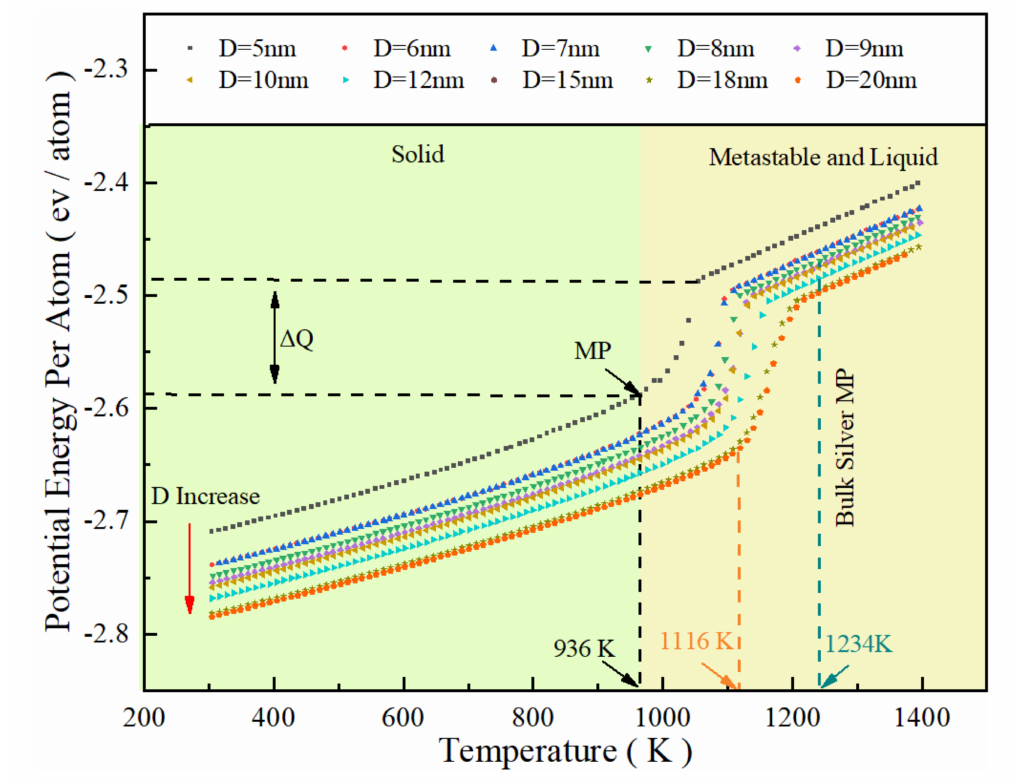
Figure 2. Potential energy of SP-5 as a function of heating